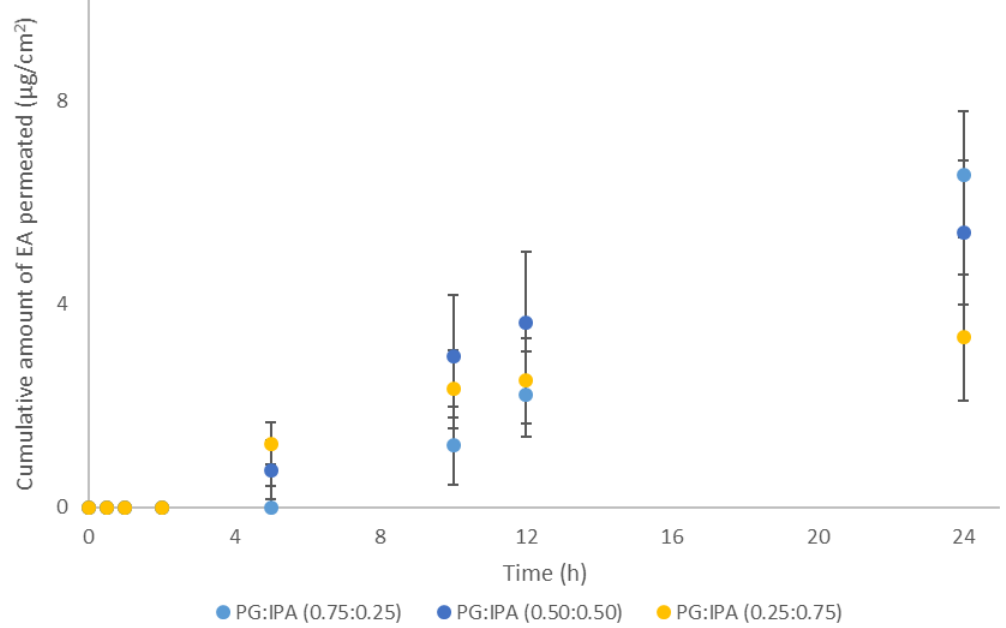
Figure 3. Cumulative permeation of 3-O-ethyl l-ascorbic acid over time for solvent systems consisting of PG:IPA at various ratios ( n ≥ 4; mean ± SD, ).